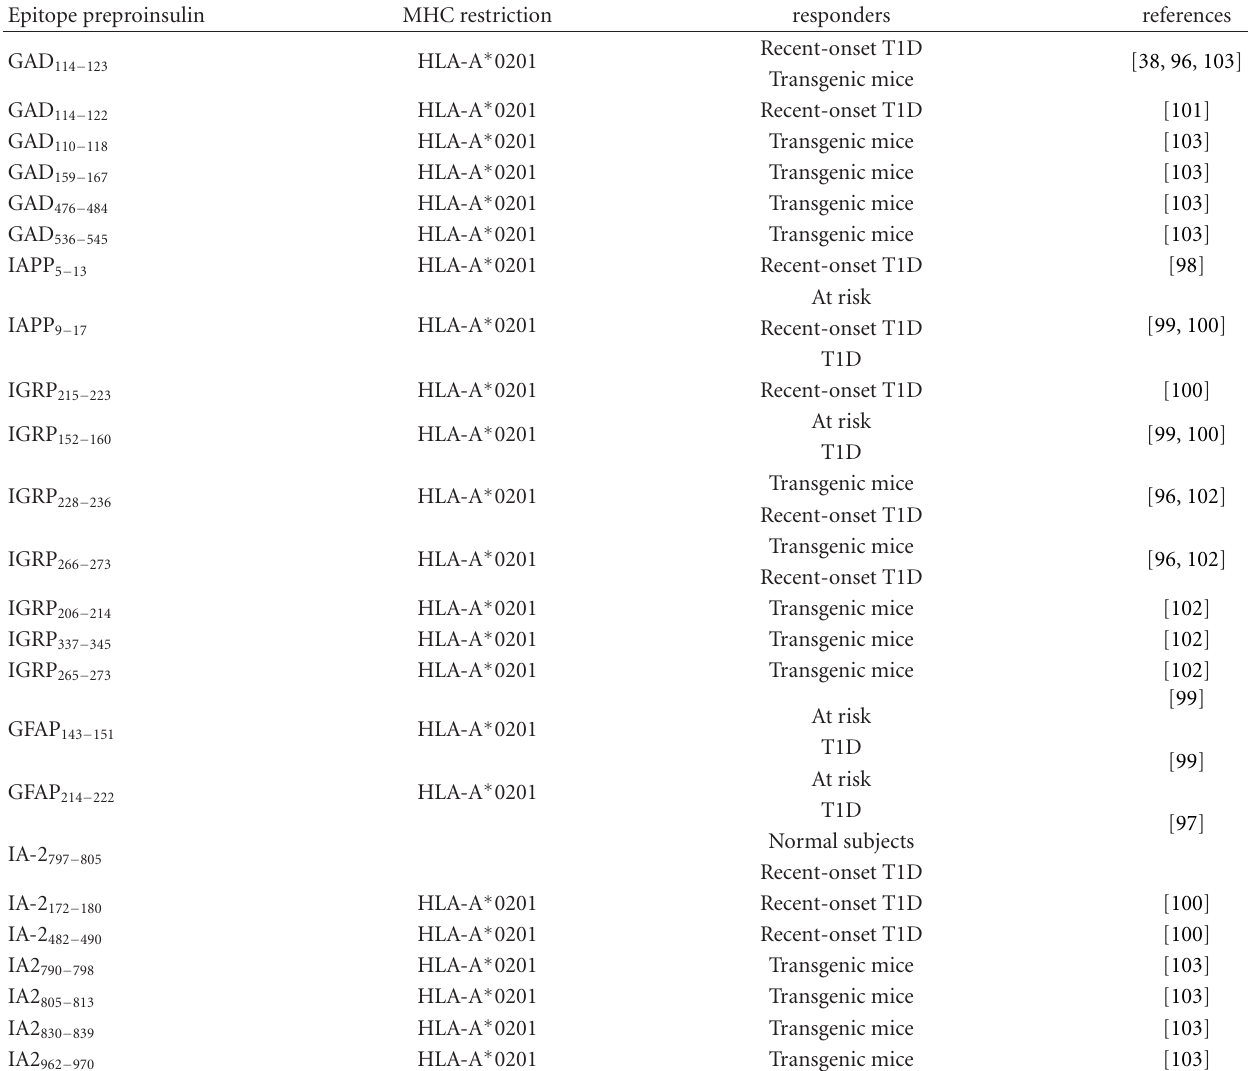
Table 4: CD8 + T-cell epitopes of human T1D autoantigens (other than